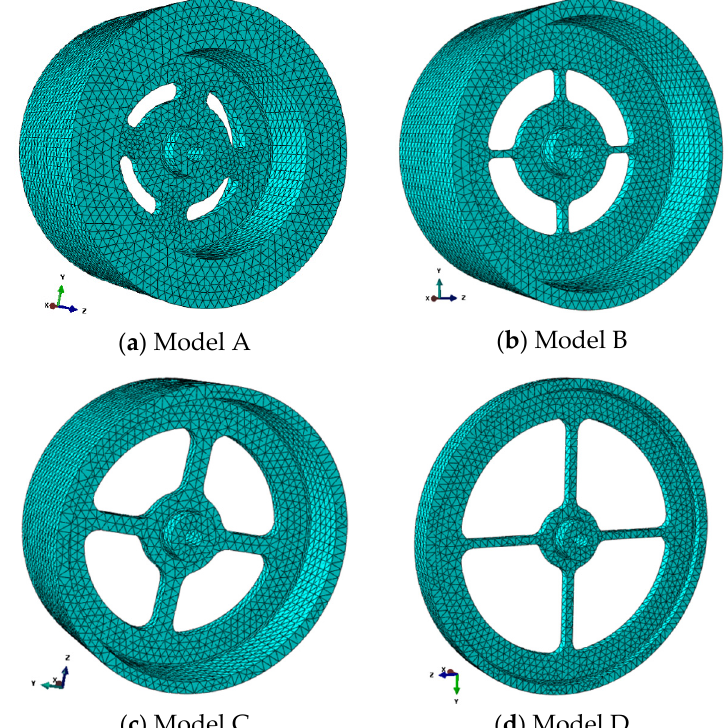
Figure 5. Finite element rapid modelling.